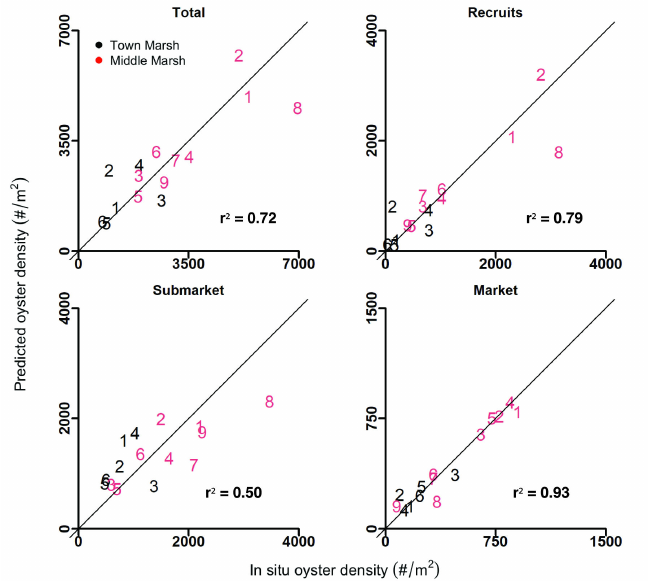
Figure 3. Intertidal oyster density predicted from GAMs for each size class total, recruit (<25 mm), submarket (25–76 mm), market ( ≥ 76 mm) that incorporated spectral and structural metrics derived from UAS and SfM products in relation to in situ oyster density. Black line represents the 1:1